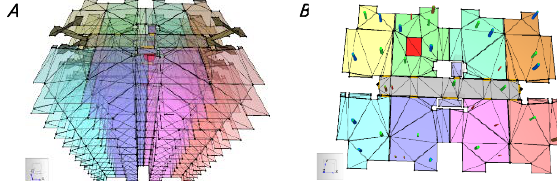
Figure 5. Triangulation network in Pathfinder software to route individuals from (a) top-facing views of all classes without agents and (b) top the 4 th floor with